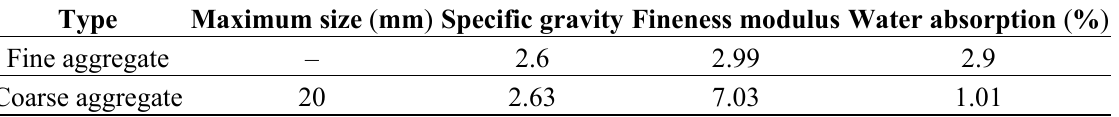
Table 4. Physical properties of